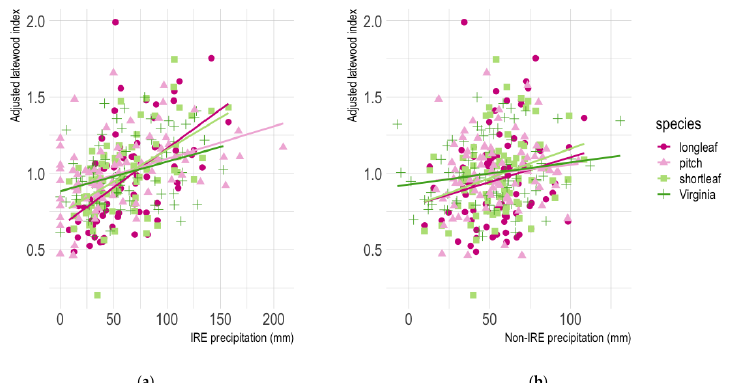
Figure 3. Scatterplot of adjusted latewood, IRE precipitation ( a ), and non-IRE precipitation ( b ) for each species during 1940–2020. All pine species except Virginia pine have significant ( p < 0.001) associations with IRE precipitation ( a ) while no species have significant associations with non-IRE precipitation ( b ). No significant ( p < 0.05) trends in either IRE or non-IRE precipitation occurred during the study period.